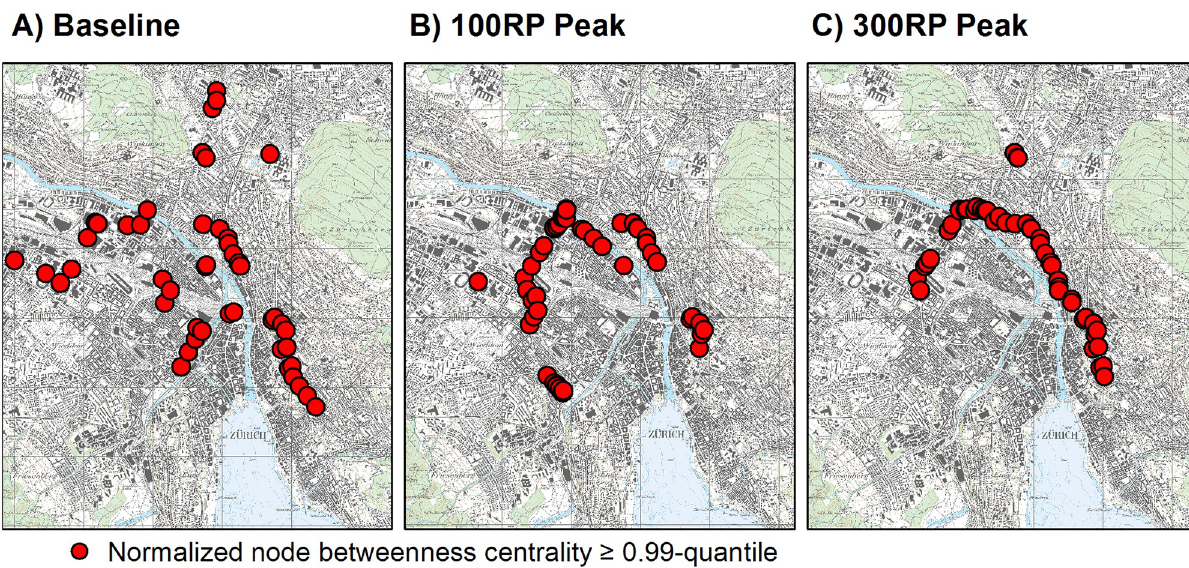
Fig 3. Spatial distribution of node betweenness centrality for Zurich road network under baseline conditions (A) or peak flood scenarios (B, C). Results were calculated for system of roads at least 3 m wide. Betweenness centrality was evaluated for each network node by dividing number of shortest paths through nodes by total number of shortest paths within network. Values of betweenness were normalized with (N-1)(N-2), where N was number of nodes under baseline conditions. Figure presents values equal to or larger than 0.99-quantiles. Reprinted from National Map 1:25000 on sheet 1091 under a CC BY license, with permission from the Federal Office of Topography Swisstopo (original copyright 2019).